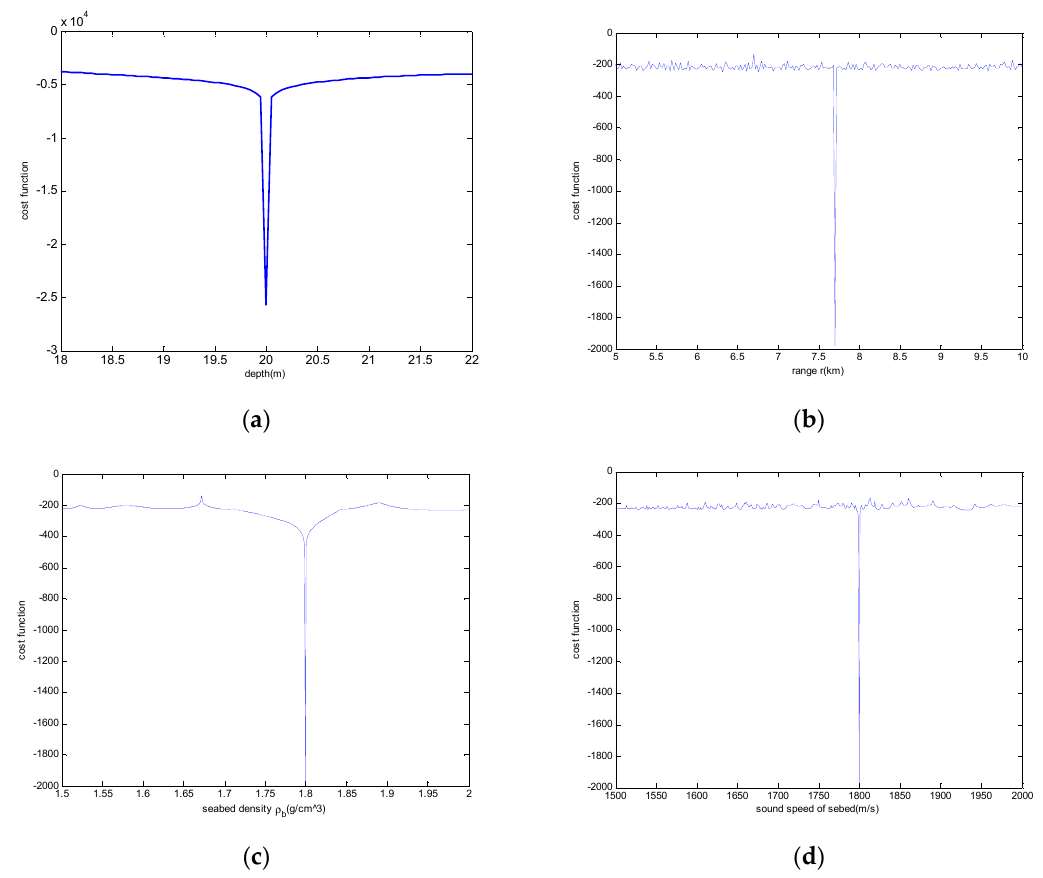
Figure 5. Inversion parameter sensitivity analysis to the cost function. ( a – d ) are analysis results of four inversion parameters (source range, depth, seabed sound speed, and seabed density), respectively.